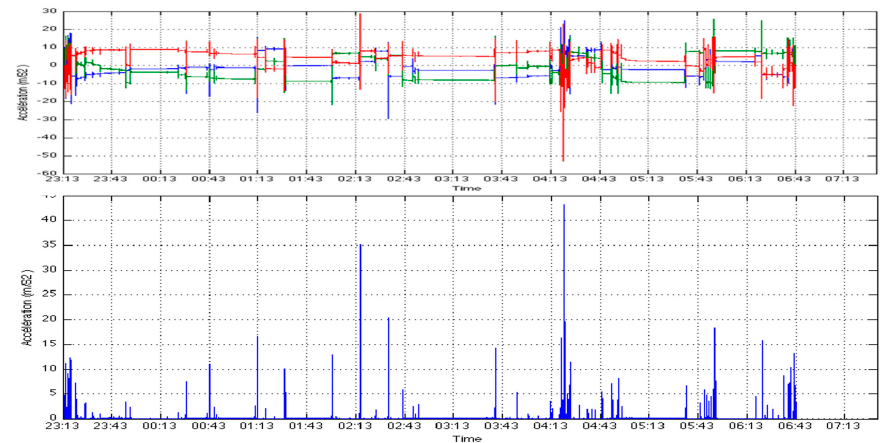
Figure 6. The raw acceleration of the right wrist along the three axes and its module shown below.